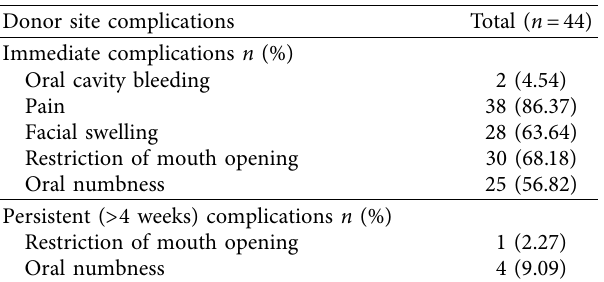
Table 4: Postoperative donor site